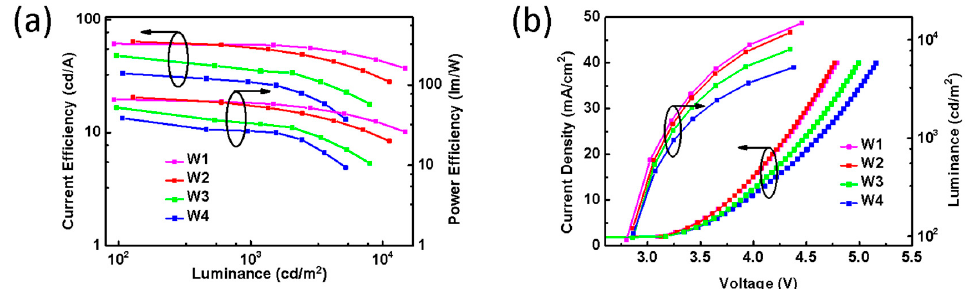
Figure 3. ( a ) Current efficiency–luminance–power efficiency characteristics of W1, W2, W3, and W4. ( b ) Current density–voltage–luminance curves of those ( b ) Current density–voltage–luminance curves of those devices. Table 1. Summary of voltages, power efficiency (PE), current efficiency (CE), external quantum efficiency (EQE), Commission International de I’Eclairage (CIEs) coordinates, and color temperature (CCT) of the devices for W1 to W4. a), b) Voltages were measured corresponding to the onset and 1000 cd/m 2. c) CIE coordinates and CCT values were measured at 100 cd/m 2 . WOLEDs